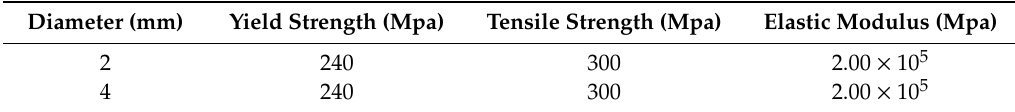
Table 2. Mechanical properties of galvanized steel wire.